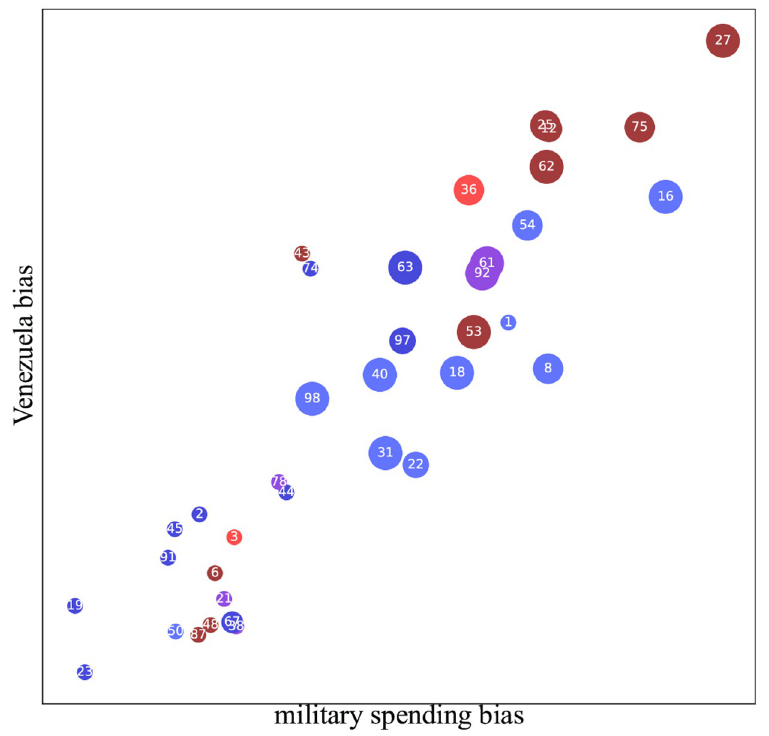
Fig 8. Correlation between military spending bias and Venezuela bias.